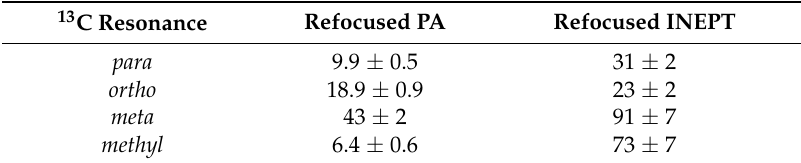
Table 1. Signal-to-noise ratios (SNR) for SABRE-enhanced 13 C{ 1 H} NMR spectra of 4-MP acquired with the refocused PA and refocused INEPT pulse sequences. Values are the average over 7 (PA) and 3 (INEPT) repeat